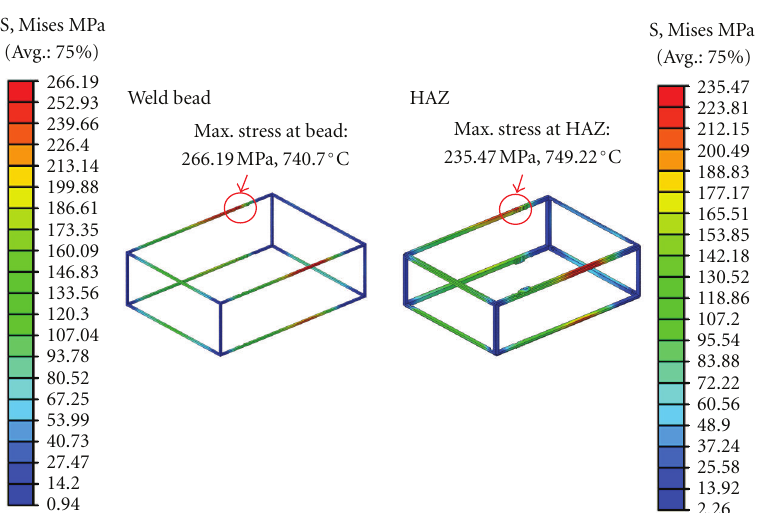
Figure 14: Stress contours of a 3kW class PHE prototype in the weld zone from an elastic-plastic analysis using the weld material properties.